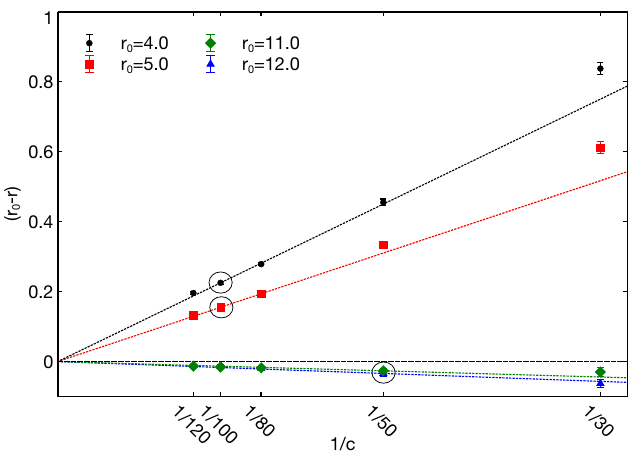
Figure 11 . For (cid:12)xed r 0 distance at N = 8, L = 8 and T = 3 : 0, we plot the probe shift ( r 0 (cid:0) r ) as a function of 1 =c . The slope of the linear relation de(cid:12)nes the force ( r 0 (cid:0) r ) = F= 2 1 =c . A deviation from the linear behavior is present when the force is large and c is too small. The dotted lines represent the slopes for our typical choices of c = 100 in the small r 0 regions and c = 50 in the large r 0 region (circled